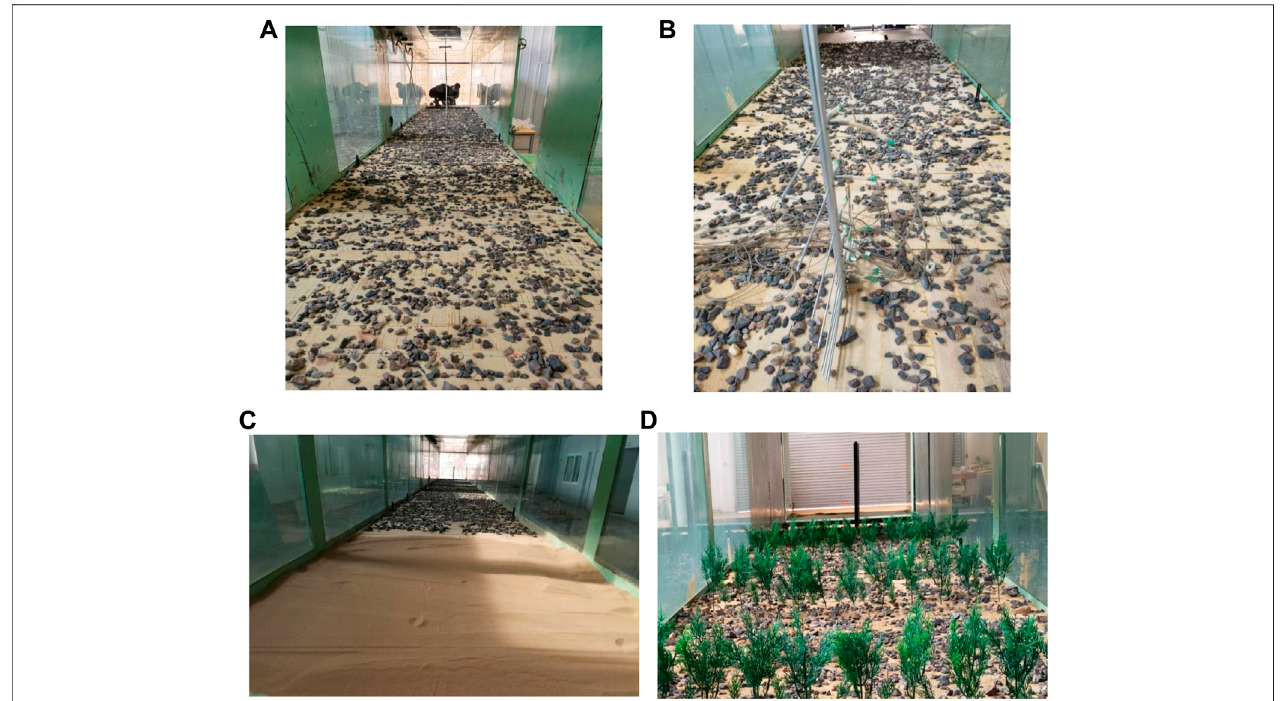
FIGURE3| ThelayoutofGobisurface,sandbeds,andplantsinthewindtunneltest. (A) :Gobibed, (B) :Flow fi eldtest, (C) :Sandbed, (D) :Sedimenttransporttest.